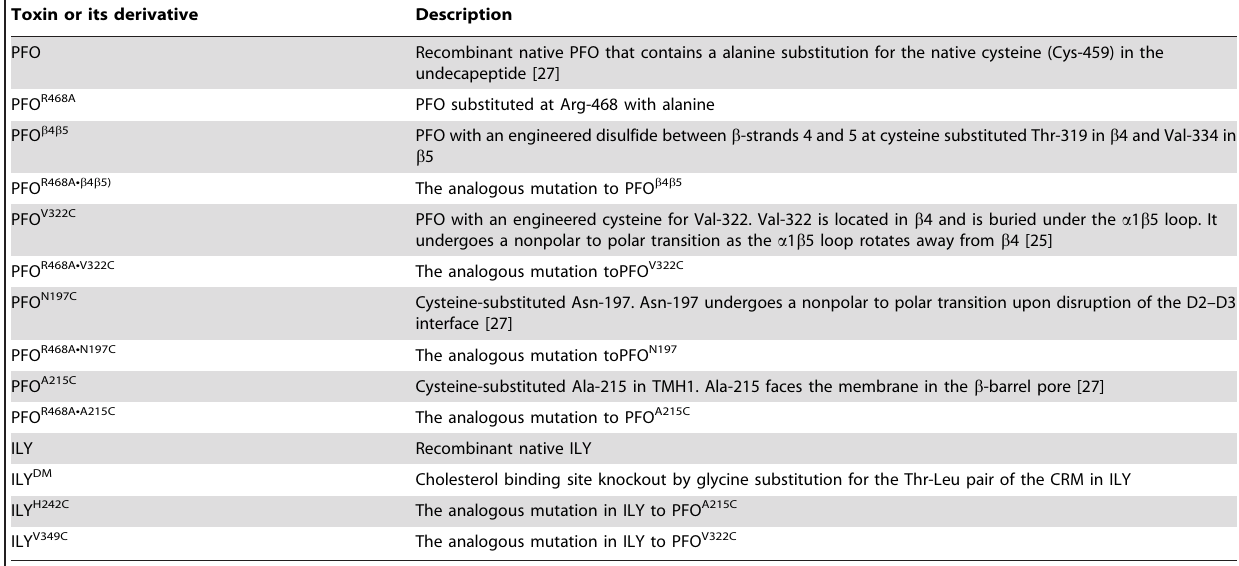
Table 2. PFO and its derivatives used